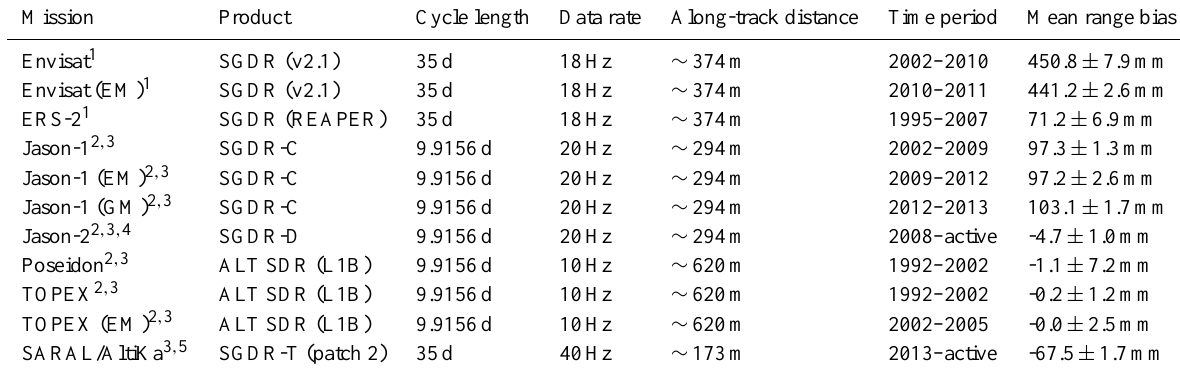
Table 1. List of all altimeter missions used in this study together with their main characteristics. Mission Product Cycle length Data rate Along-track distance Time period Mean range bias Envisat 1 SGDR (v2.1) 35d 18Hz ∼ 374m 2002–2010 450.8 ± 7.9mm Envisat (EM) 1 SGDR